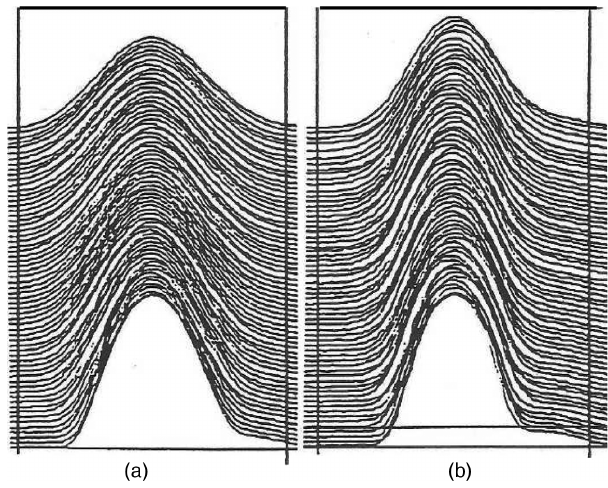
FIG. 2. Measurements made in the CERN SPS at energy 300 GeV of the longitudinal distribution of (a) a proton bunch ( N þ ¼ 1 . 5 × 10 11 ) and (b) an antiproton bunch ( N − ¼ 1 . 2 × 10 10 )